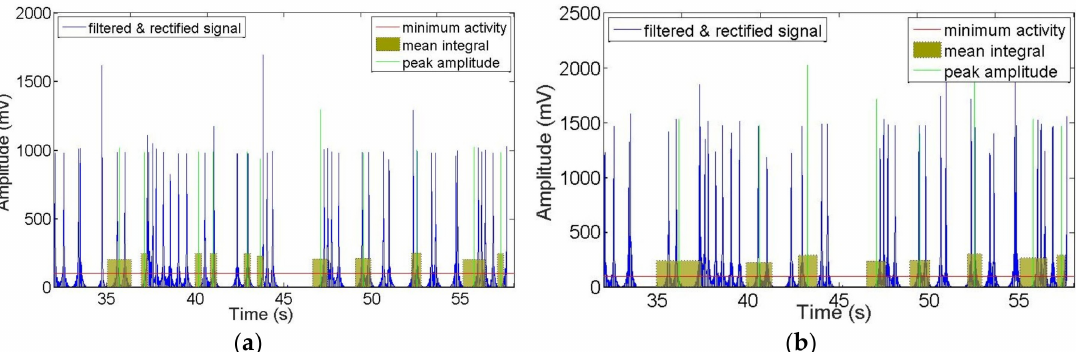
Figure 12. Recorded EMG signals at left and right sides of gluteus medius muscle locations during passive cycling: ( a ) Left side; ( b ) Right side.